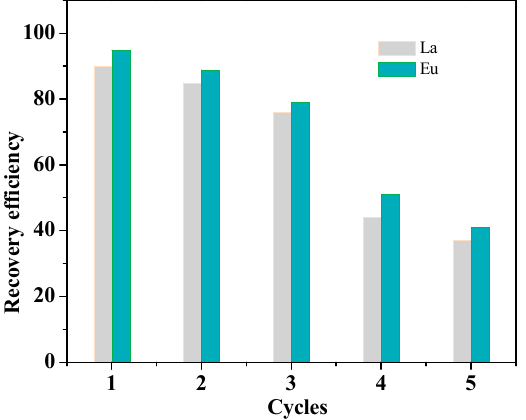
Figure 7. The recovery efficiency of La(III) and Eu(III) ions using regenerated L2.